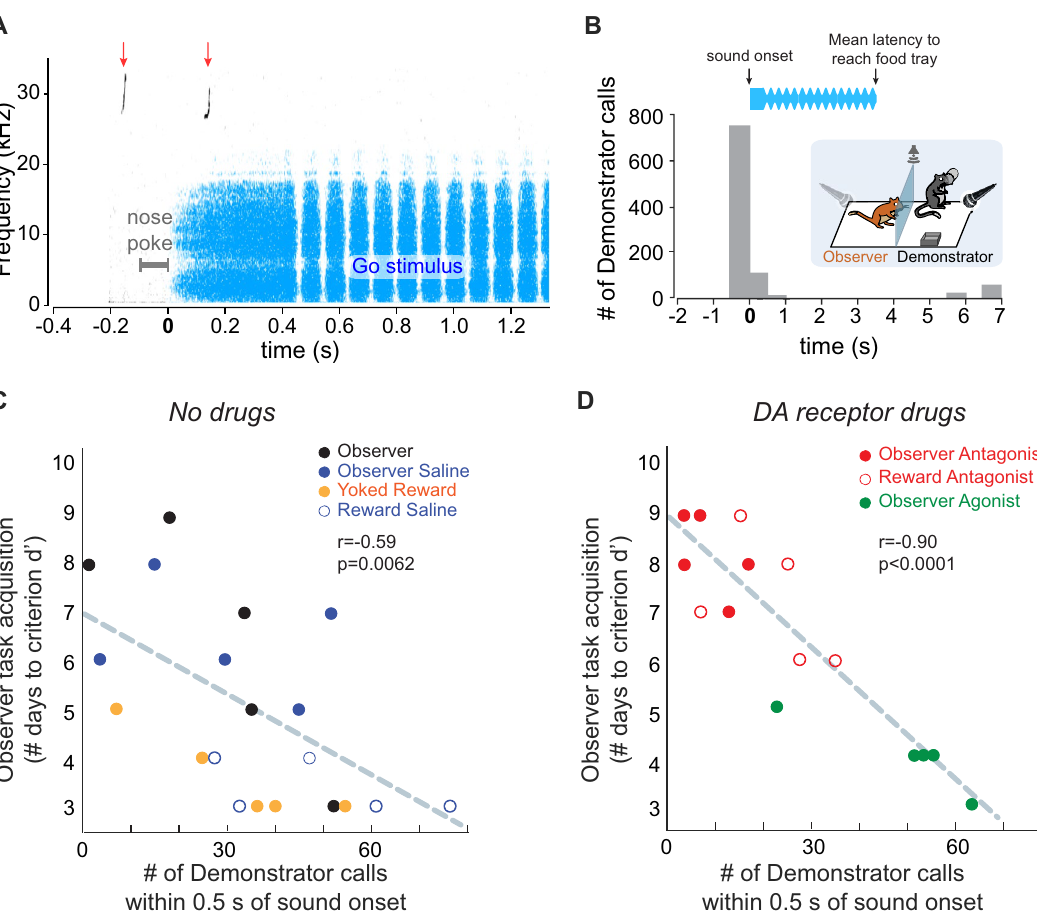
Figure 4. Time-locked demonstrator vocalizations with sound onset may provide key social cues to observers. ( A ) Example vocalizations of a demonstrator during an exposure session. ( B ) Histogram of time-locked demonstrator vocalizations as a function of the sound stimulus onset. ( C ) Mean number of time-locked demonstrator calls (within ± 0.5 s of the sound onset) plotted against the number of days taken by the respective observers to reach the criterion d ′ of 1.5. Data are from the no-drug-treated demonstrator-observer pairs. ( D ) Mean number of time-locked demonstrator calls against the number of days taken by the drug-treated observers to reach the criterion d ′ of